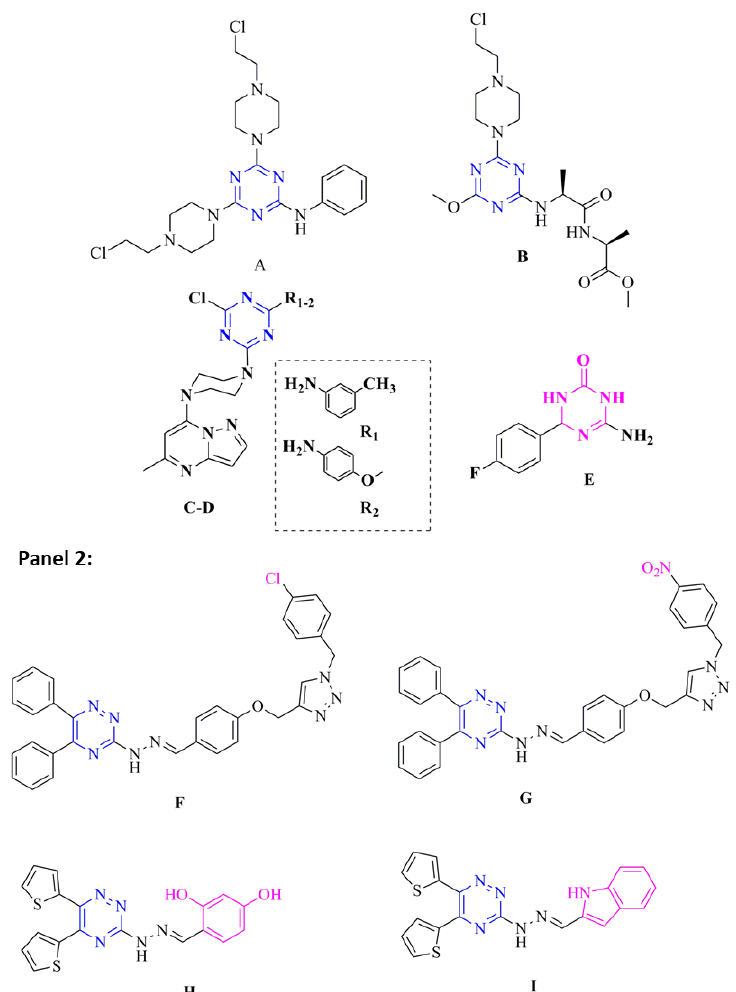
Figure 1. Panel 1: structures of previously obtained triazine compounds A and B , triazine-triazolopyrimidine derivatives as multitarget compounds for the treatment of Alzheimer’s disease (compounds C and D ), and triazinone simultaneously modulate BACE-1 and GSK-3β (compound E ). Panel 2: Structures of 3-hydrazinyl 1,2,4-triazine scaffold containing pendant phenoxy methyl-1,2,3-triazole ( F and G ) and 1,2,4-triazines linked to the different arylhydrazone moieties as a dual metal chelator and BACE1 inhibitor with antioxidant potential ( H and I